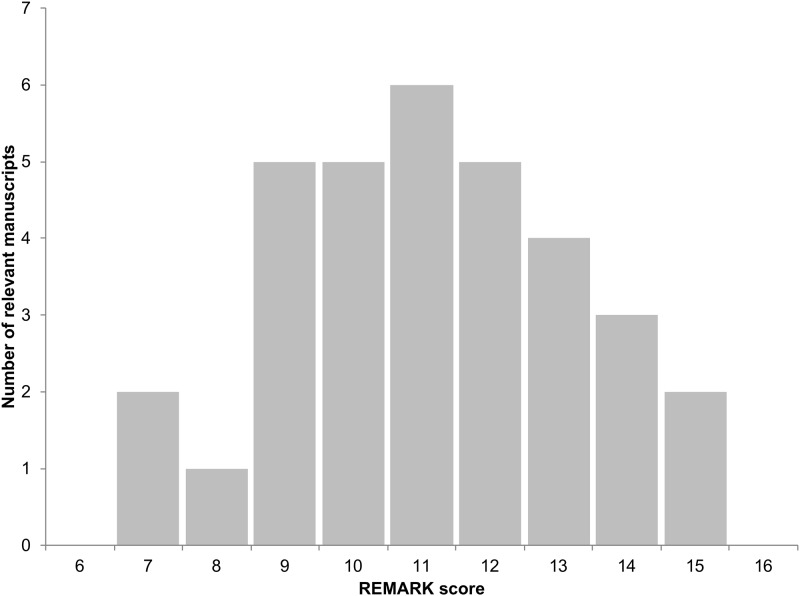
Distribution of REMARK scores in valid manuscripts.Histogram depicting the range of REMARK scores from relevant RCC circulating prognostic biomarker manuscripts identified in this study.